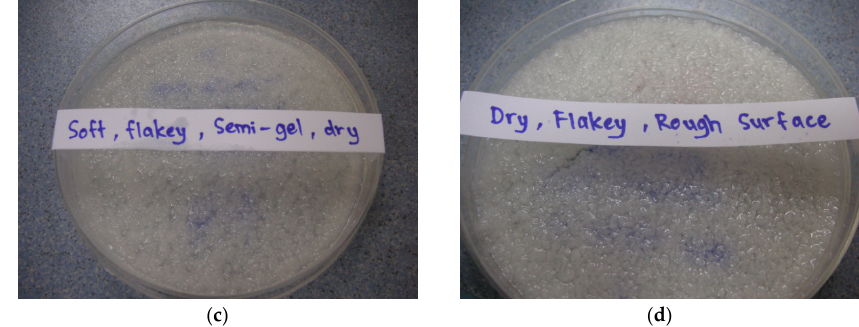
Figure 1. Appearance of ionically crosslinked hydrogels. ( a ): Hydrogels with a slightly flakey but overall smooth surface; ( b ) Hydrogels with soft texture and rough surface; ( c ) Semi ‐ gel, soft hydrogels with flakey and dry surface ; ( d ) Hydrogels with dry, flakey, rough surface.